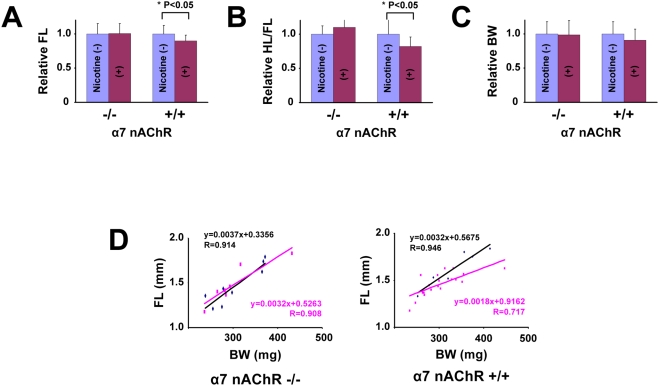
Maternal nicotine exposure in alpha7 nAChR-disrupted mice.A–C: FL, HL/FL, and body weight (BW) of alpha7 nAChR −/− and alpha7 nAChR +/+ E15.5 littermate fetuses. Alpha7 nAChR +/− female were mated with alpha7 nAChR +/− male, and given drinking water with or without nicotine during pregnancy. Relative FL, HL/FL, and BW were calculated, each value in mice that did not receive nicotine was regarded as equal to 1.0. Nicotine significantly reduced FL and HL/FL in alpha7 nAChR +/+ fetuses but not in alpha7 nAChR −/− fetuses (A,B). Nicotine did not significantly reduce BW in either genotype (C). D: Scatterplot and correlation between the FL and BW of mice with (red line) or without (black line) exposure to nicotine. In alpha7 nAChR +/+ fetus, Nicotine downwardly shifts the linear slope in alpha7 nAChR +/+ fetuses but not in alpha7 nAChR −/− fetuses.